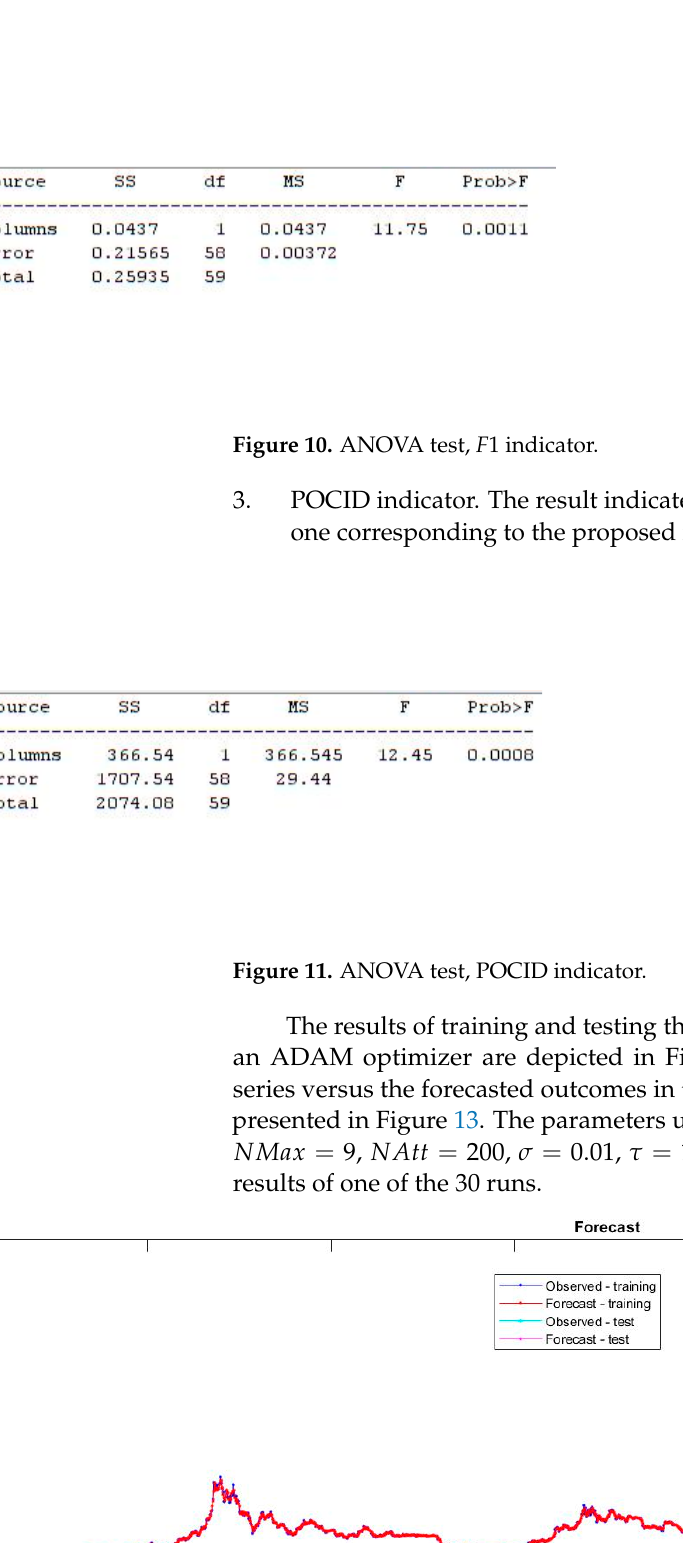
Figure 9. ANOVA test, MAPE indicator. 2.